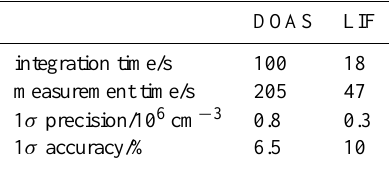
Table 1. Performance of the J¨ulich LIF and DOAS instruments dur- ing experiments in SAPHIR in summer